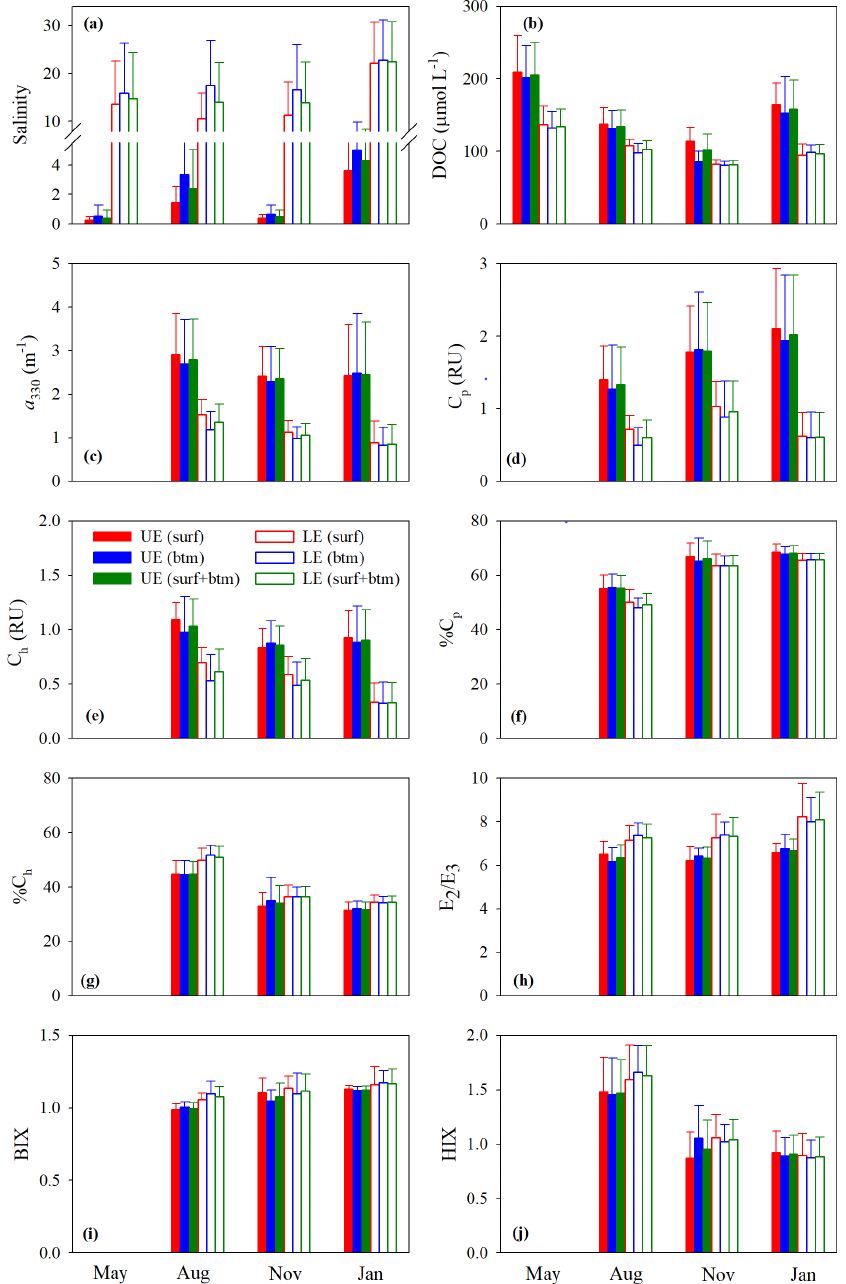
Figure 3. Mean values of salinity (a) , [DOC] (b) , a 330 (c), C p (d) , C h (e) , %C p (f) , % C h (g) , E 2 / E 3 (h) , BIX (i) , and HIX (j) in the upper (UE) and lower (LE) estuaries. UE and LE refer to areas upstream and downstream of station M05, respectively (Fig. 1). Surf and btm stand for surface and bottom respectively, and surf + btm denote surface combined with bottom. Error bars are 1 standard deviation.